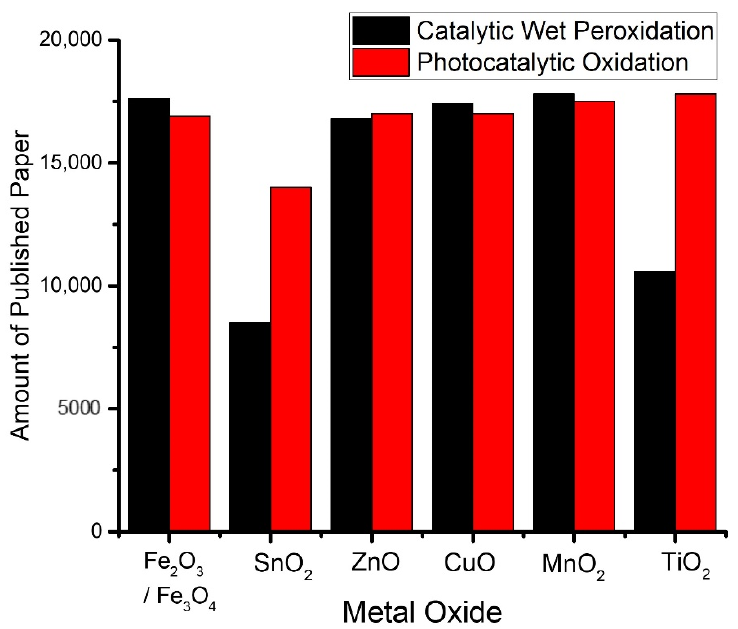
Figure 3. The popularity of metal oxides in AOPs observed based on publications during 2019–2020.